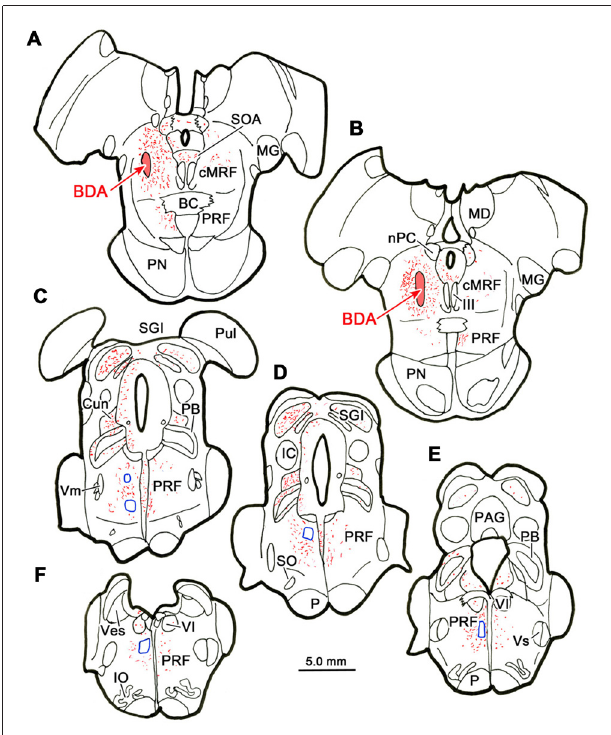
FIGURE 7 | Location of electron microscopic (EM) samples from the PRF. The distribution of labeled terminals (stipple) and axons (lines) observed following a small BDA injection into the cMRF (A,B) is charted on a rostral to caudal series of sections through the midbrain (A–E) and pons (A–F) . The location of areas sampled for electron microscopy is indicated by blue